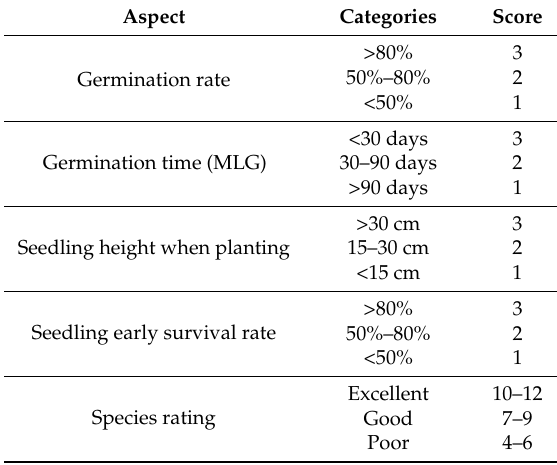
Table 2. Components of the species rating system and their assigned scores.